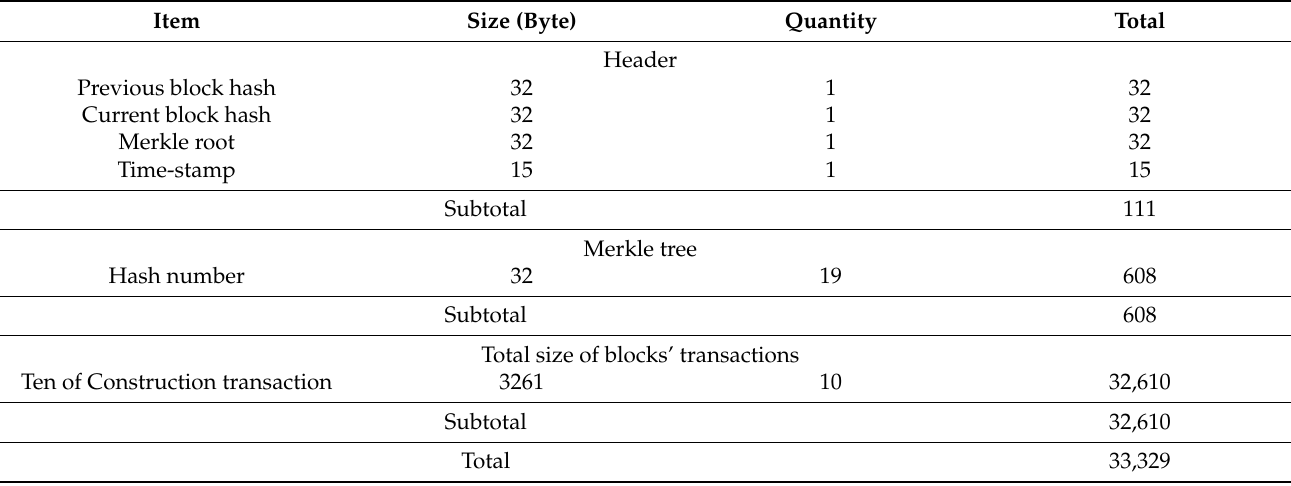
Table 6. Storage size calculation in the block.